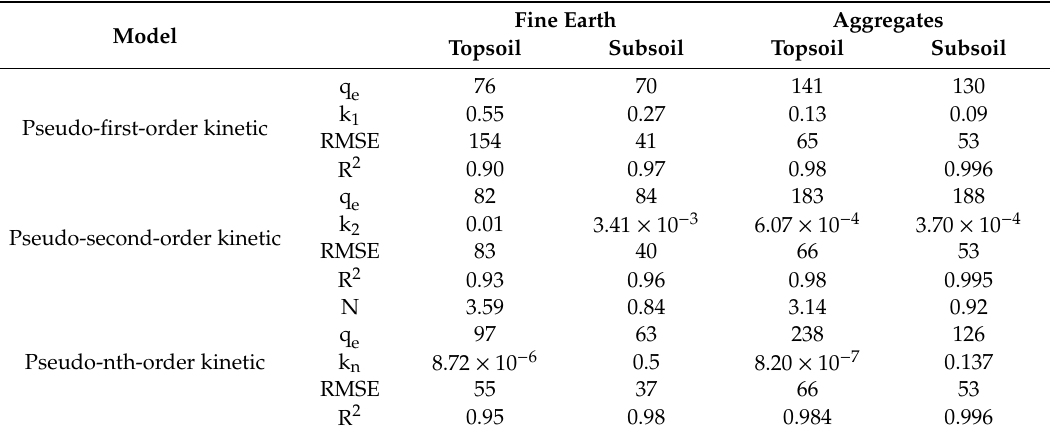
Table 2. Optimized parameter values of the various kinetic